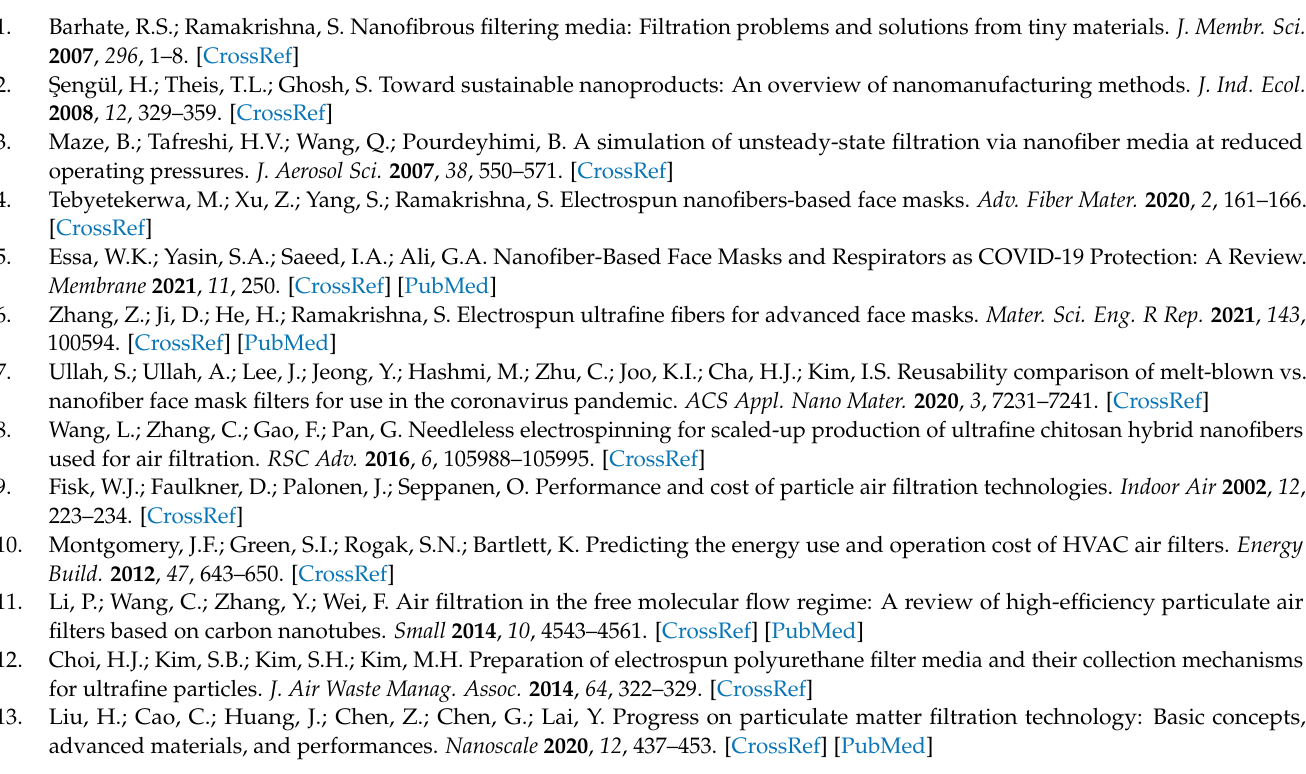
filtration test. Figure S3: Pneumatic symbol of the humid air supply setup for the filter discharging. Figure S4: Image of the apparatus for electrostatic charging of the multi-layer filter by a cyclic air blower. Figure S5: Schematics and diameter distributions of the 13 wt% electrospun PVDF nanofiber (a,b) without and (c,d) with nylon mesh on the Al foil collector. Figure S6: Correlation of the electrospinning time for PVDF NF membrane fabrication and its thickness. Figure S7: QF of a single layer filter due to the presence of electrostatic charges with the NF membrane fabrication time according to PM size. Figure S8: Pressure drop of the multilayer filter as a function of number of stacking layers after dry or humid air penetration for 0.5 h. Table S1: Comparison of absolute humidity of normal breathing of adults with continuous air flow in the apparatus to control the absolute humidity. Table S2: Power of airflow to bending filter layer during normal breathing condition and cyclic air blowing condition. Table S3: Density thickness of the PVDF bulk and NF membrane film for porosity calculation. Table S4: Characteristics of the commercial disposable face mask filter via pressure difference, filtration efficiency, and QF